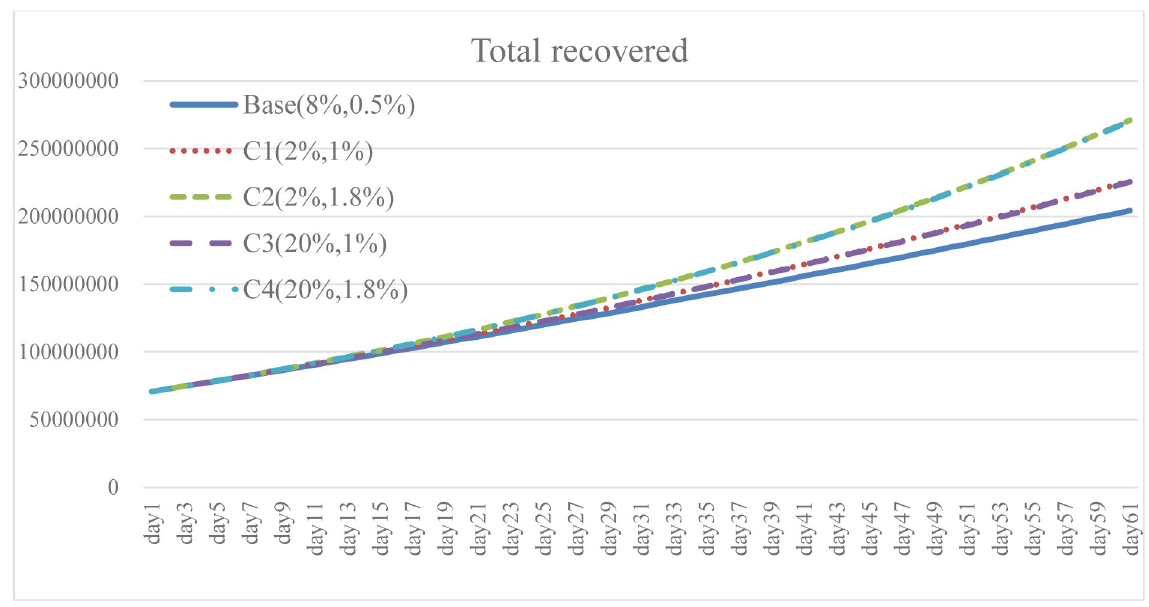
Fig 18. Total recovered under different isolation percentage and vaccine supply.